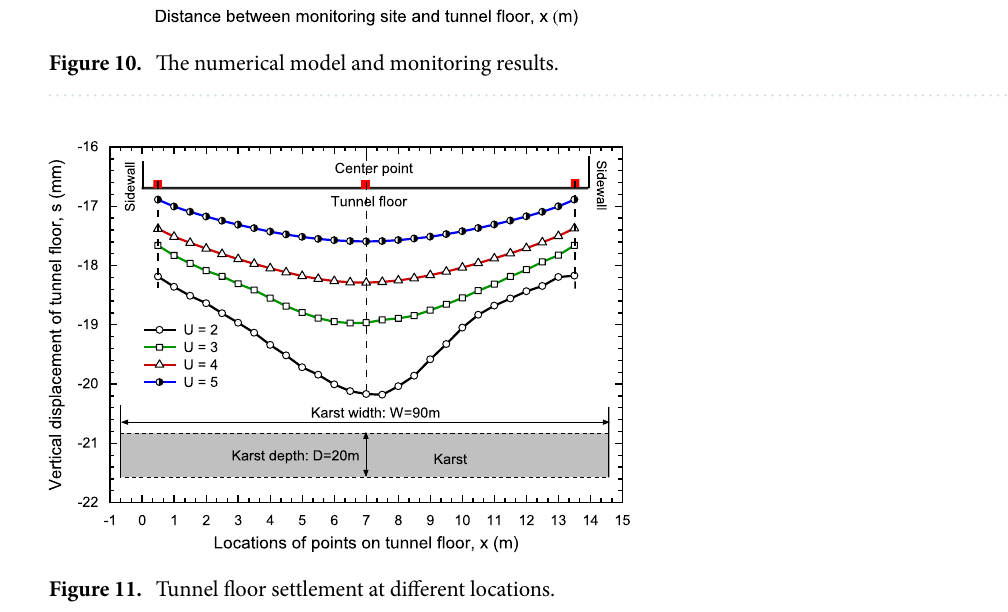
Figure 11. Tunnel floor settlement at different locations.